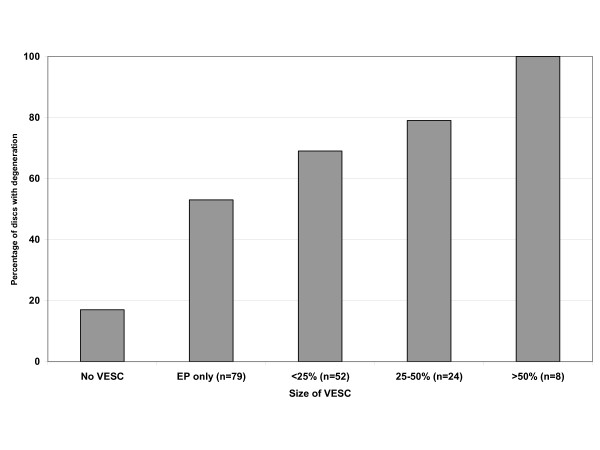
VESC and disc degeneration. The percentage of discs with degeneration (decreased signal or reduced height) in relation to the size of adjacent VESC.